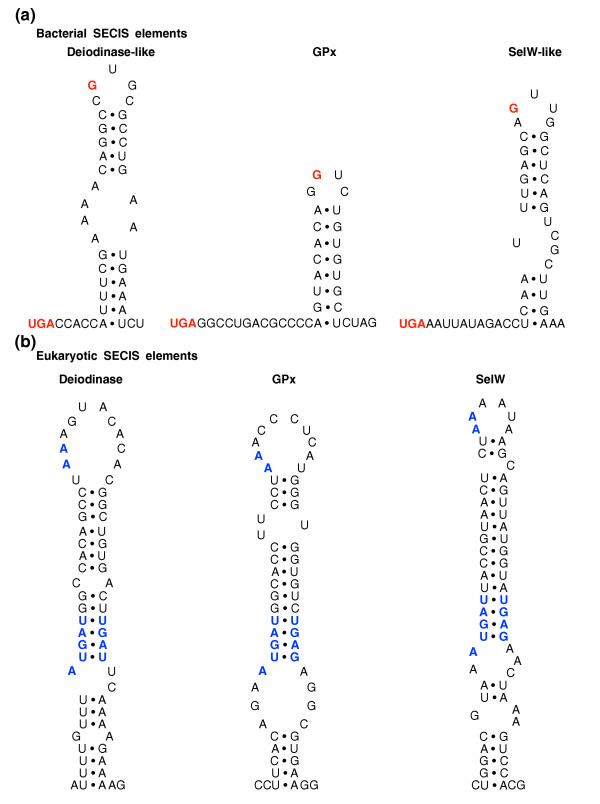
Comparison of bacterial and eukaryotic SECIS elements in deiodinase, GPx and SelW protein sequences. (a) In bacterial SECIS elements, only sequences downstream of in-frame UGA codons are shown and the conserved features (in-frame UGA codon and conserved G in the apical loop) are highlighted in red. (b) In eukaryotic SECIS elements, conserved features (quartet, AA in the apical loop or bulge and an A preceding the quartet) are shown in blue. Bacterial elements are from deiodinase-like protein, AACY01143874; GPx, AACY01190440; and SelW-like protein, AACY01475618. Eukaryotic elements are from deiodinase, NM_000792, Homo sapiens; GPx, X68314, H. sapiens; SelW, AY221261, Danio rerio.